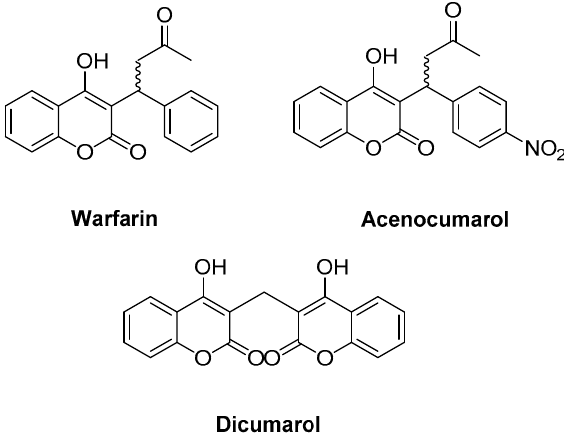
Figure 49. Chemical structure of the most common anticoagulant drugs.